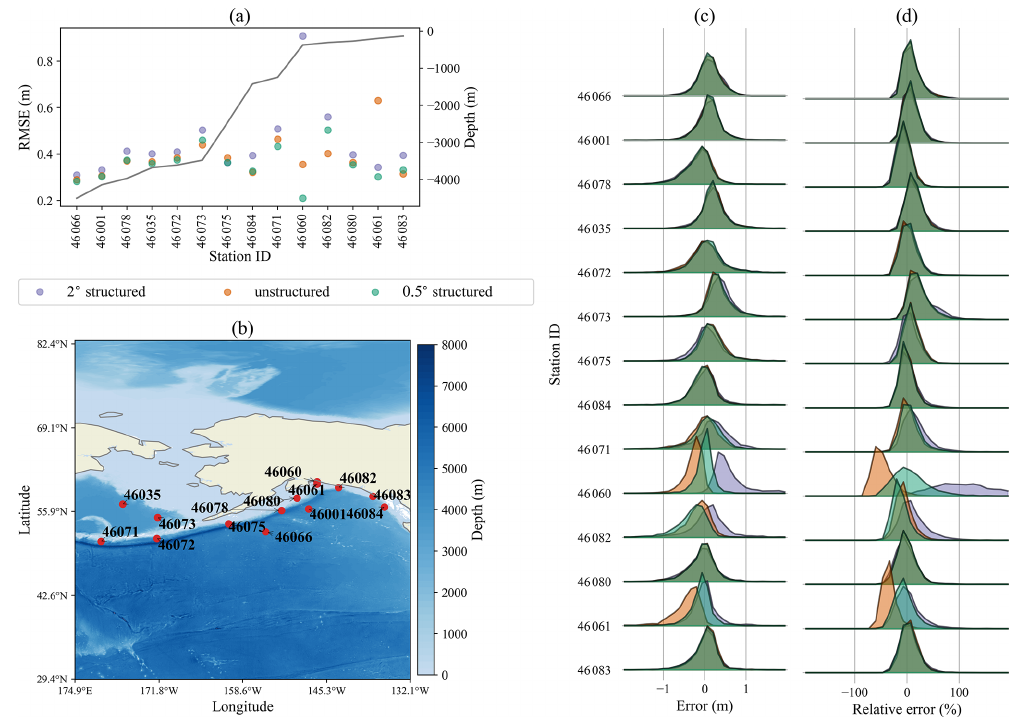
Figure 9. Same as Fig. 3 for stations in the Alaskan coastal